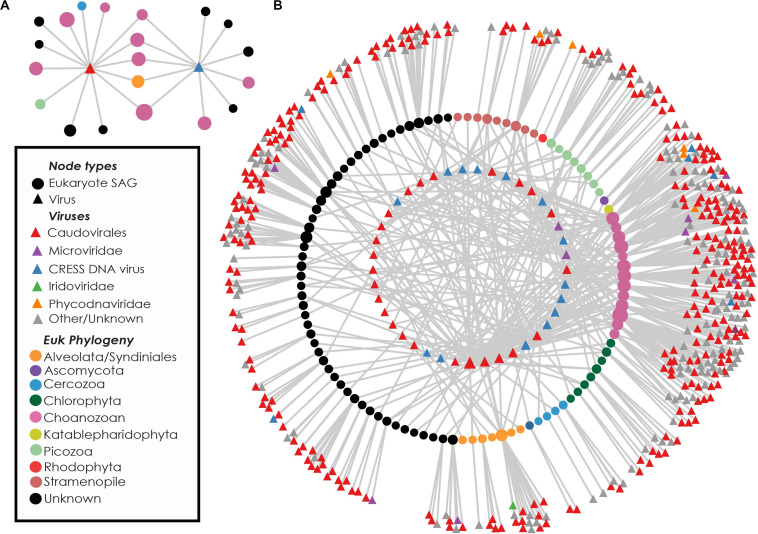
Recovery of highly similar viral sequences from multiple Gulf of Maine protistan SAGs. Example networks containing two viruses recovered from multiple eukaryotic phyla. Connections indicate occurrence of viral sequences (triangles) within protist SAGs (circles) (A). Network diagram showing viral content of eukaryote cells containing at least one virus found in multiple phyla. Innermost circle of nodes represent viruses found in more than one SAG. Middle circle of nodes represents protist SAGs. Outer nodes are singleton viral sequences. Nodes are sized based on network connectivity, with larger nodes indicating higher connectivity (B).